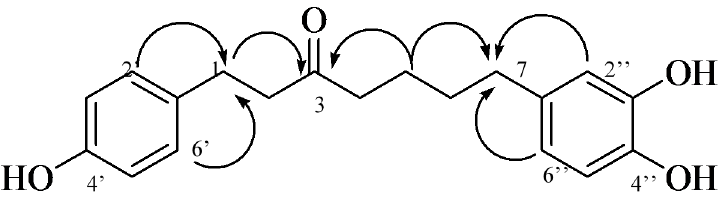
Figure 2. Important HMBC correlations of compound 1 .